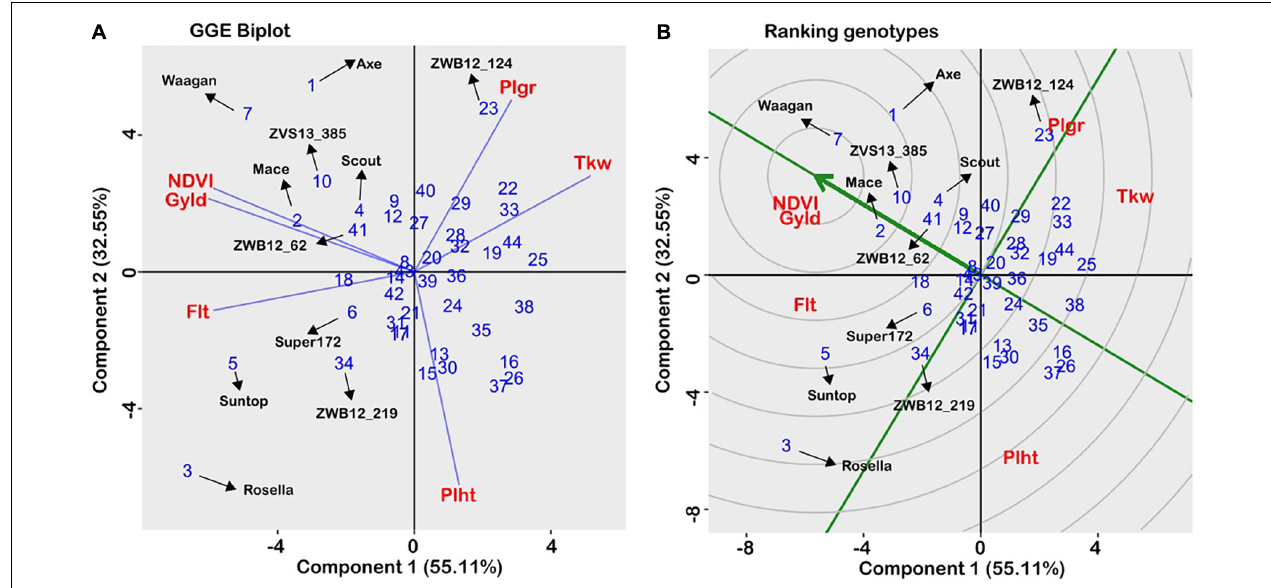
FIGURE 5 | GGE biplot of a genotype × trait matrix averaged over two years, using trait-focussed SVP, and Double-Centred GE with scaling by standard deviation. (A) Polygon plot of “which won where.” The numbers refer to individual wheat accessions (see Table 1 ), and abbreviations are given for trait names. Flt, flowering time; Gyld, Grain yield; NDVI, Normalised difference vegetative index; Tkw, Thousand kernel weight; Plht, Plant height. (B) Ranking the accessions in relation to the “ideal”